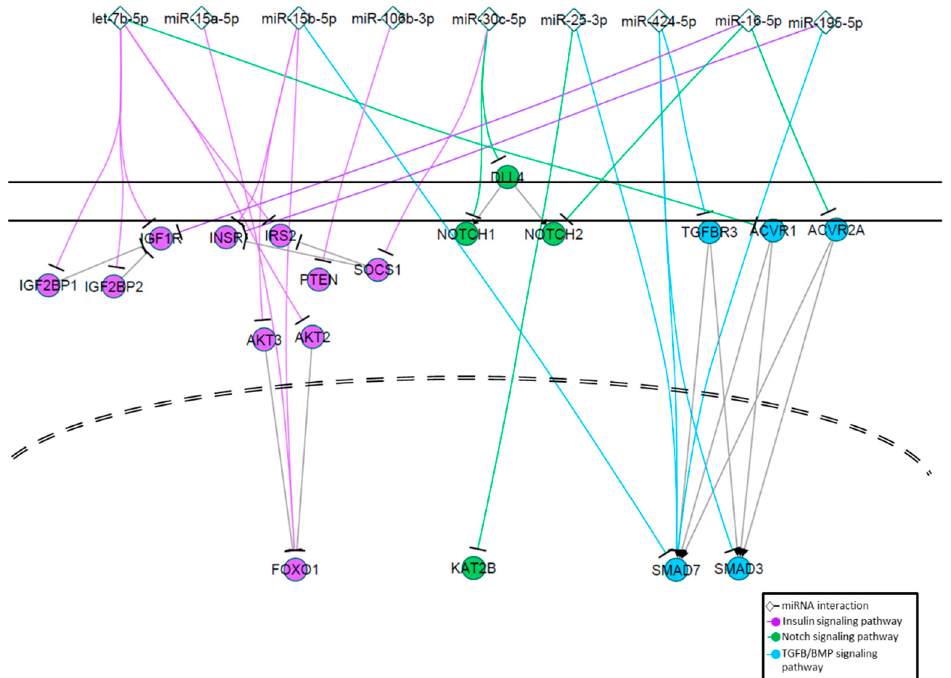
Figure 8. Signaling pathways modulated by EV miRNAs associated with T2DM. Pathway diagram showing selected EV miRNAs (diamonds) that change in response to metformin treatment directly regulating critical targets of insulin signaling (purple), Notch signaling (green), and TGF β /BMP signaling (cyan).